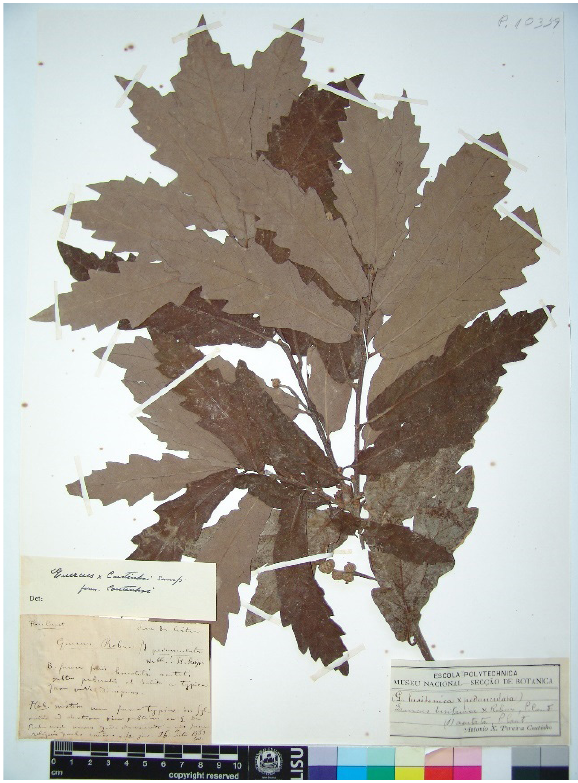
Figure 9. Holotype of Quercus × sampaioana Vila-Viçosa, Capelo, P. Alves, R. Almeida & F.M. Vázquez nothosp. nov . (LISU –